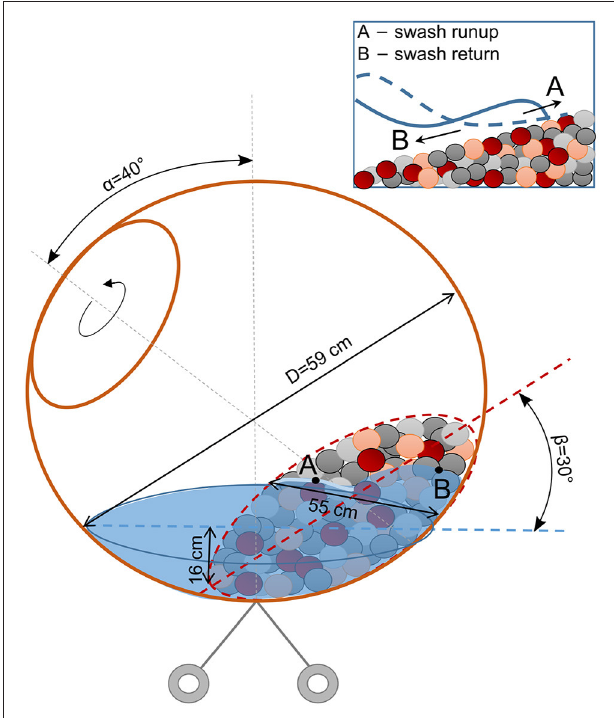
FIGURE 4 | Mixing process in detail: swash runup in area (A) and swash return in area (B) .